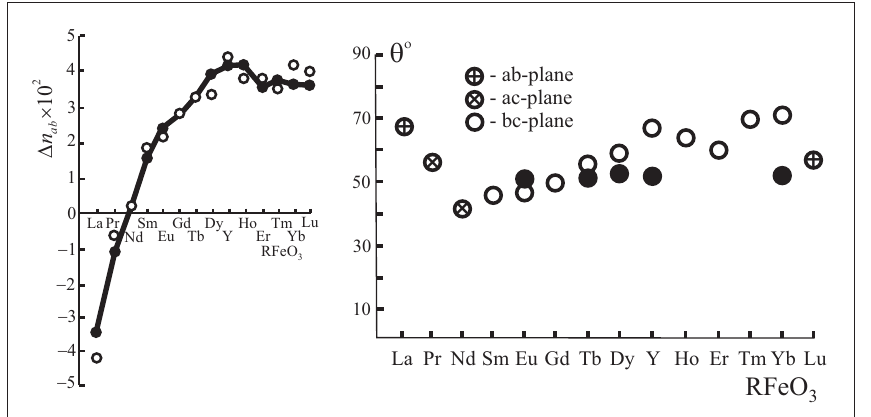
Figure 4. Left panel: Linear birefringeance ∆ n ab for orthoferrites RFeO 3 in ab plane. Solid circles are predictions of the deformation model; hollow circles are experimental data ( λ = 0.633 µ m) [66]. Right panel: The orientation angles ( ± θ ) of optical axes in respective planes of orthoferrites predicted by the deformation model. The solid black circles are scarce experimental data for bc plane ( λ = 0.68 µ m) [67,68]. Adapted from